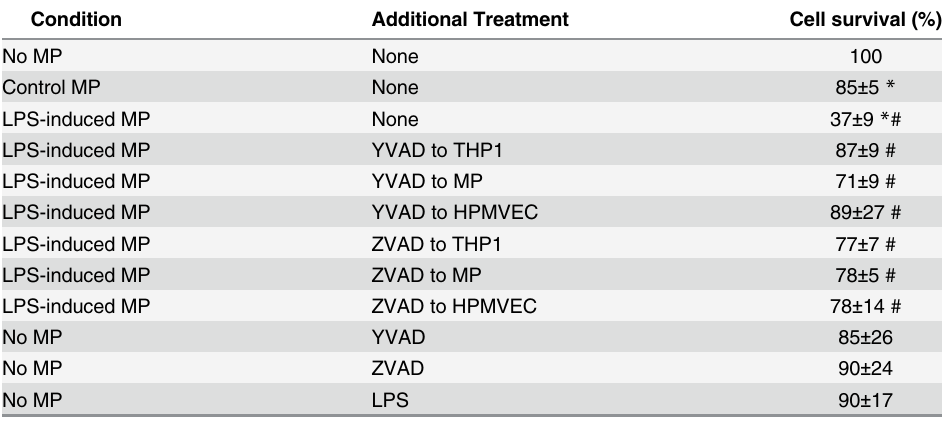
Table 1. Effect of caspase-1 inhibition on microparticle-induced HPMVEC apoptosis. Condition Additional Treatment Cell survival (%) No MP None 100 Control MP None 85 ± 5 * LPS-induced MP None 37 ± 9 * # LPS-induced MP YVAD to THP1 87 ± 9 # LPS-induced MP YVAD to MP 71 ± 9 # LPS-induced MP YVAD to HPMVEC 89 ± 27 # LPS-induced MP ZVAD to THP1 77 ± 7 # LPS-induced MP ZVAD to MP 78 ± 5 # LPS-induced MP ZVAD to HPMVEC 78 ± 14 # No MP YVAD 85 ± 26 No MP ZVAD 90 ± 24 No MP LPS 90 ± 17 THP1 cells were stimulated with LPS (1 μ g/ml) for 2h and microparticles (MP) were isolated. MPs were generated from cells in the presence or absence of speci fi c caspase-1 inhibitor, YVAD-cmk or pan-caspase inhibitor, ZVAD-fmk. Inhibitors were added either A) to the cells prior to LPS stimulation (pre-generation);